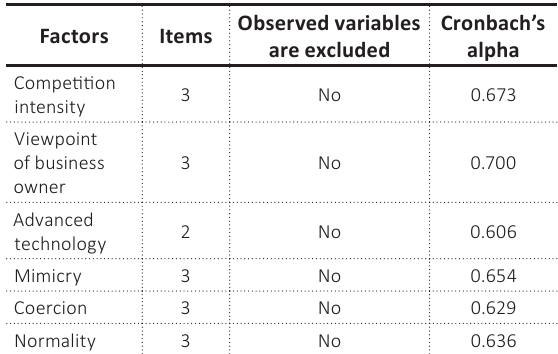
Table 1. Cronbach’s alpha values